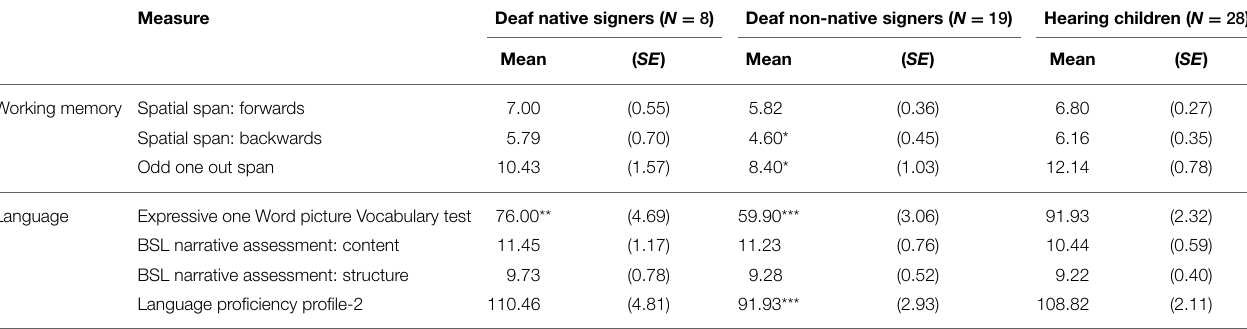
TABLE 4 | Estimated marginal means (standard error) for the language and working memory measures (controlling for age and WASI T-score), for the deaf native signer, deaf non-native signer, and hearing